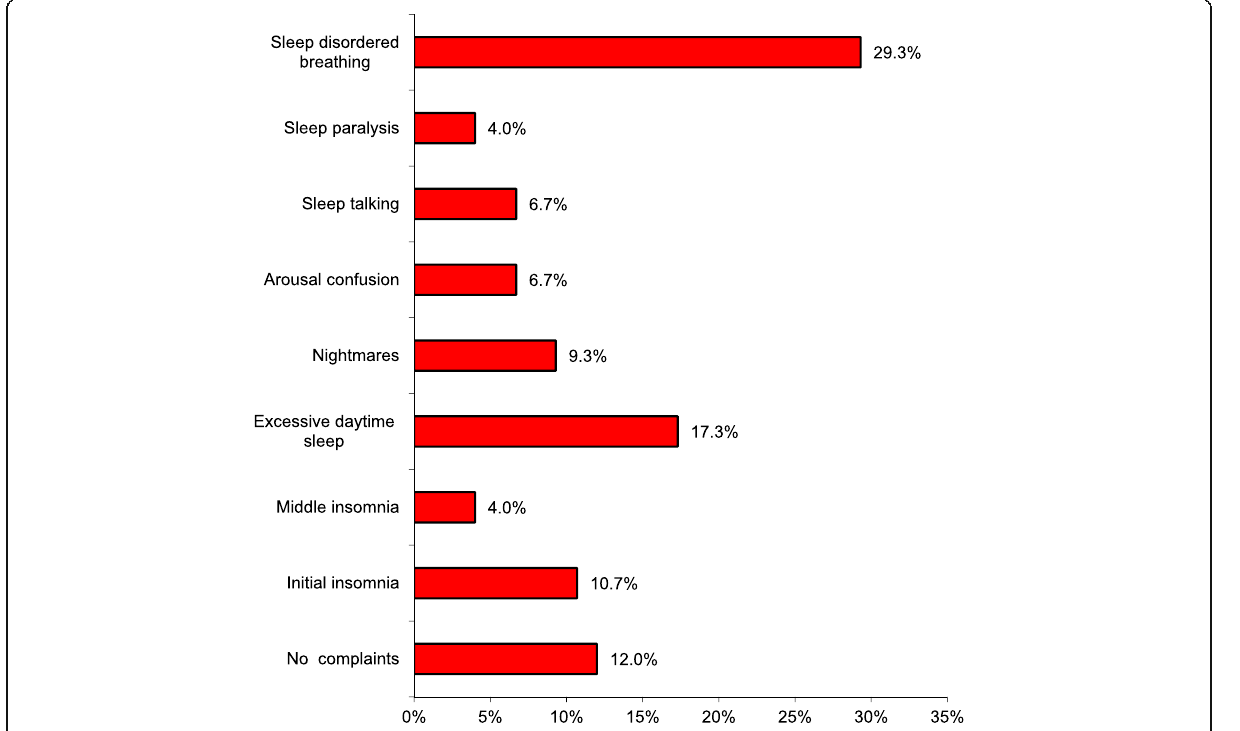
Fig. 1 Distribution of sleep phenomenon and complaints in our patients ’ sample, with SDB being the highest and EDS came second in the rank, while middle sleep insomnia accounted for the least percentage